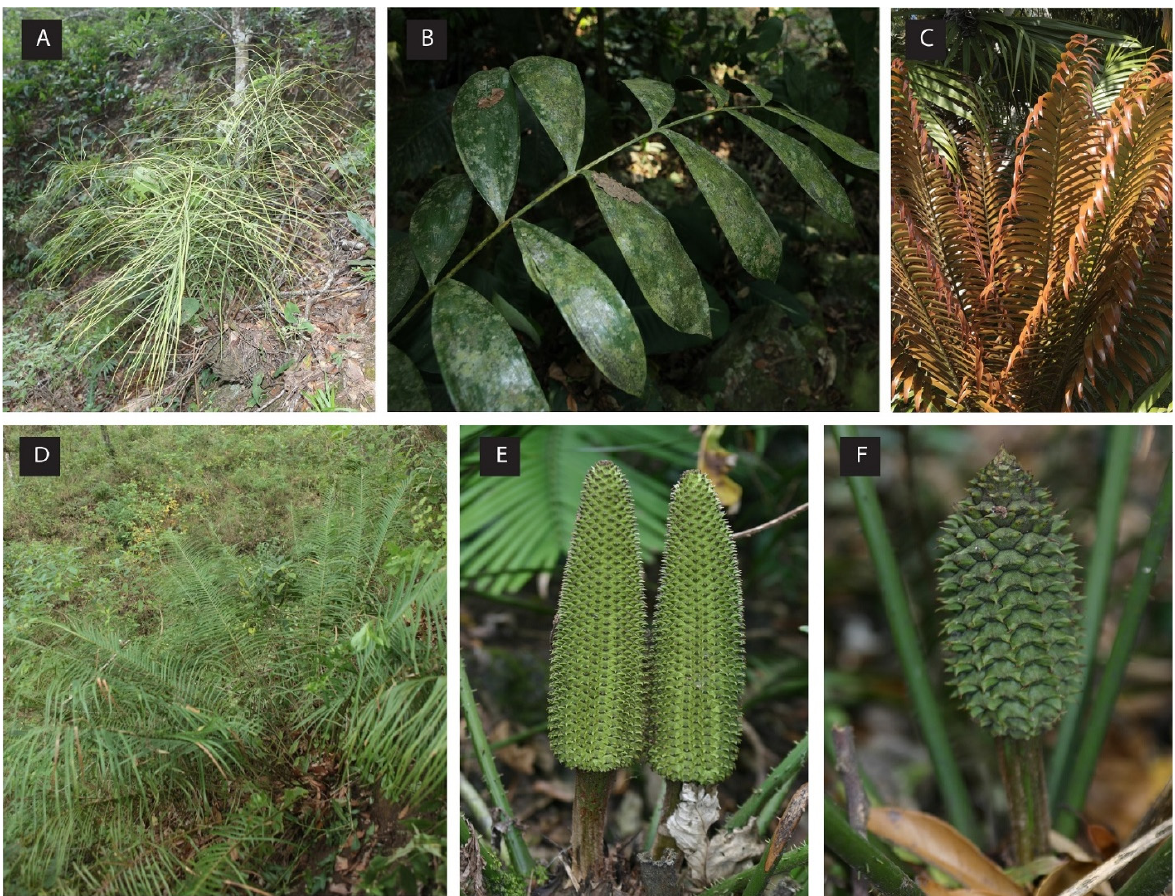
Figure 1. Species of Ceratozamia showing morphological variations. ( A ) C. norstogii, adapted for a shady, high-altitude, seasonal dry forest and displaying a twisted rachis with extremely narrow leaflets; ( B ) C. hondurensis adapted to a shady rainforest environment, and displaying broad leaflets; ( C ) C. robusta with distinct reddish-orange to dark maroon newly emerging leaflets; ( D ) C. mirandae from high-altitude open oak forest with narrow leaflets and a spreading leaf arrangement; ( E , F ) C. tenuis male vs. female cones displaying the distinct “horn-like” extensions that distinguish Ceratozamia from all other cycad genera. Photographs by Anders Lindstrom.